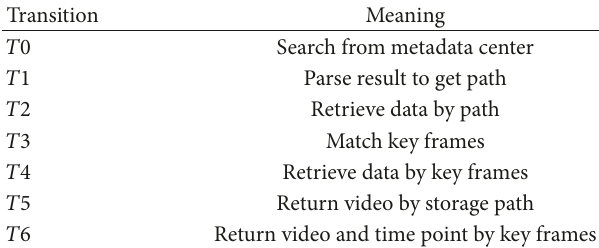
Table 2: Meaning of